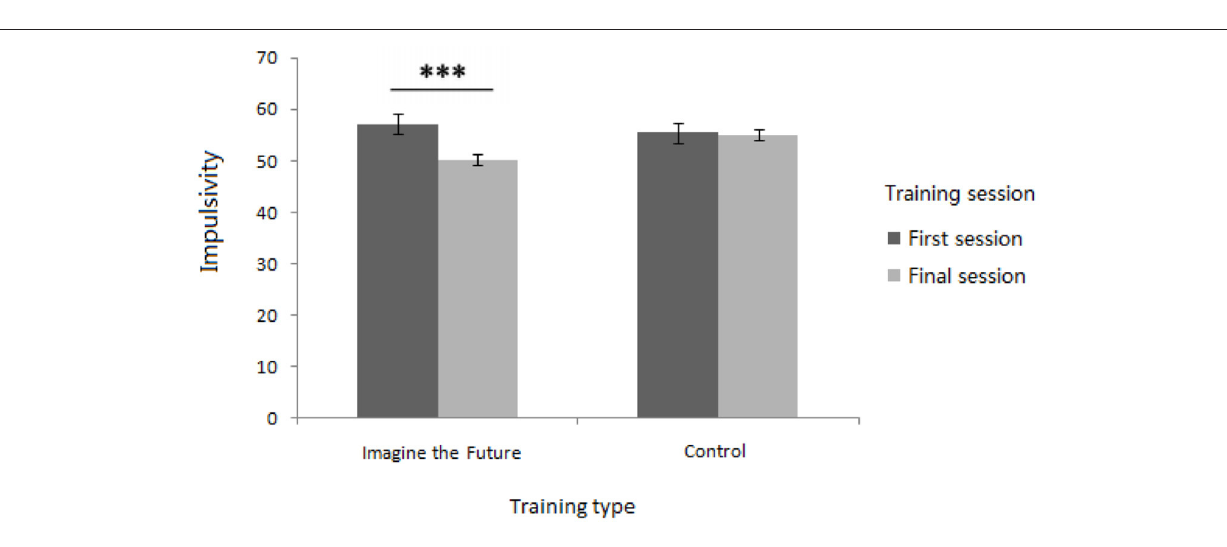
= 50.000, SD = 7.079) were significantly lower than those in the first session (M = 55.050, SD = 8.866). As for the